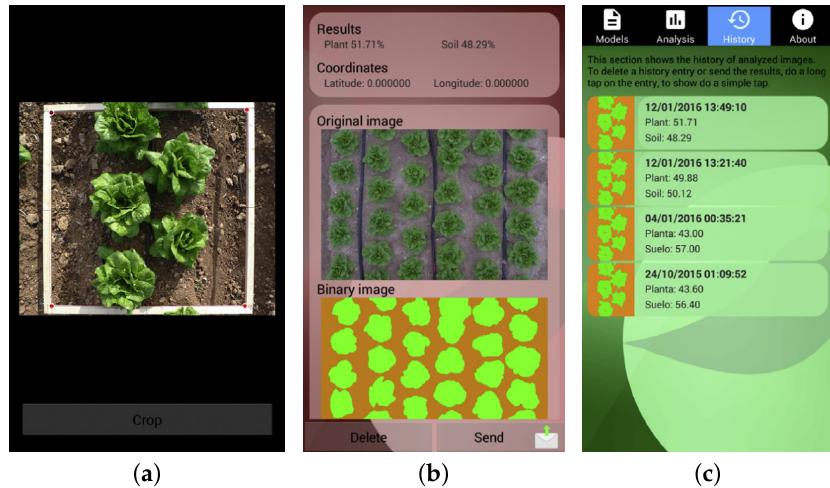
Figure 18. pCAPS: ( a ) Captured image visualization interface; ( b ) Image processing result; ( c ) History of analyzed images.